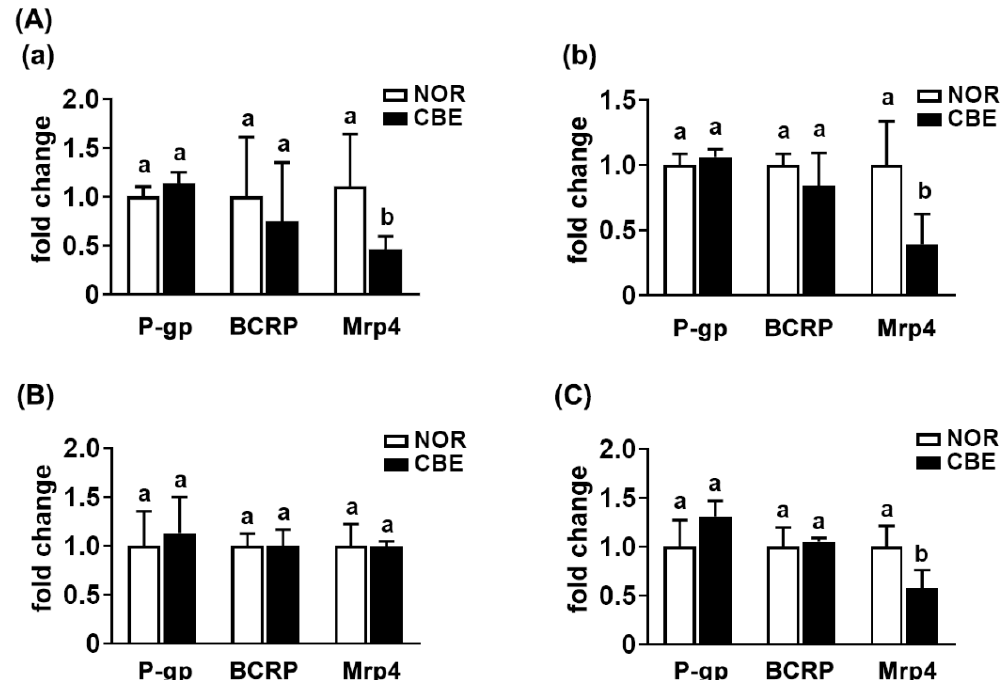
Figure 5. Effect of coffee bean extract (CBE) on the P-gp, BCRP, and Mrp4 expression in the intestines of mice. ( A ) Effect on the P-gp, BCRP, and Mrp4 expression. ( a ) Effect in the small intestine. ( b ) Effect in the large intestine. ( B ) Effects in Caco-2 cells treated with vehicle (NOR) or coffee bean extract (CBE). ( C ) Effect in Caco-2 cells treated with the fecal suspension of mice treated with vehicle (NOR) or coffee bean extract (CBE) on the transporter expression. The transporter expression was assessed by qPCR. Data are shown as the mean ± S.D. ( n = 6). Means with same letters are not significantly different ( p < 0.05).